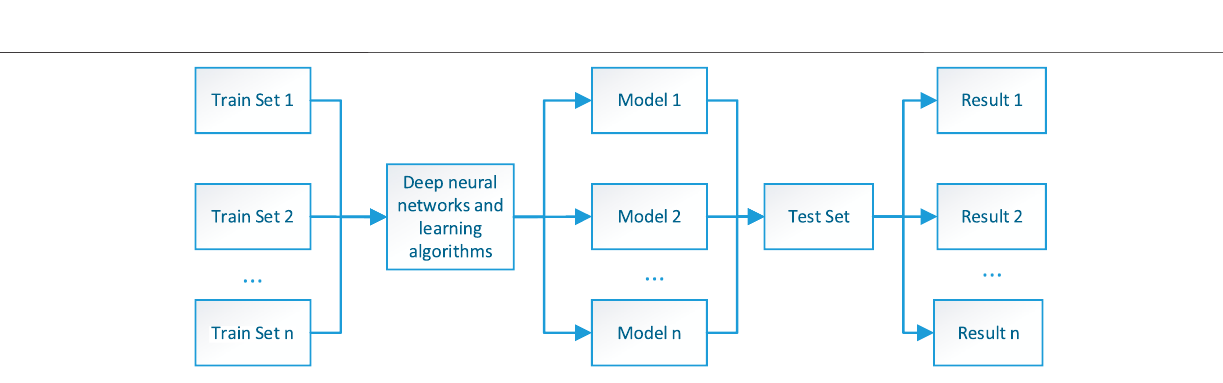
FIGURE 6 | Overall diagram of database comparison method.